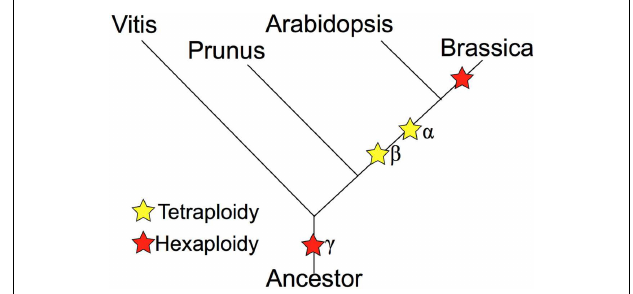
FIGURE 1 | Phylogeny of Brassica and relatives marking the relative placement of lineage divergence and polyploidy events. Polyploidies are named according to the Arabidopsis convention of α (most recent in the linage of Arabidopsis ), β (second most recent), and γ (eudicot